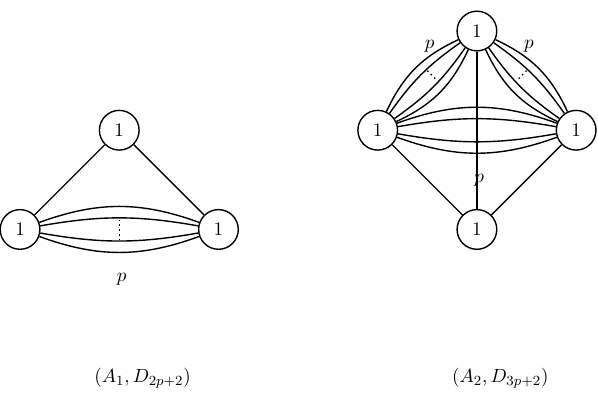
) theories, with s = 1 , 2 , and ( s +1) p +2